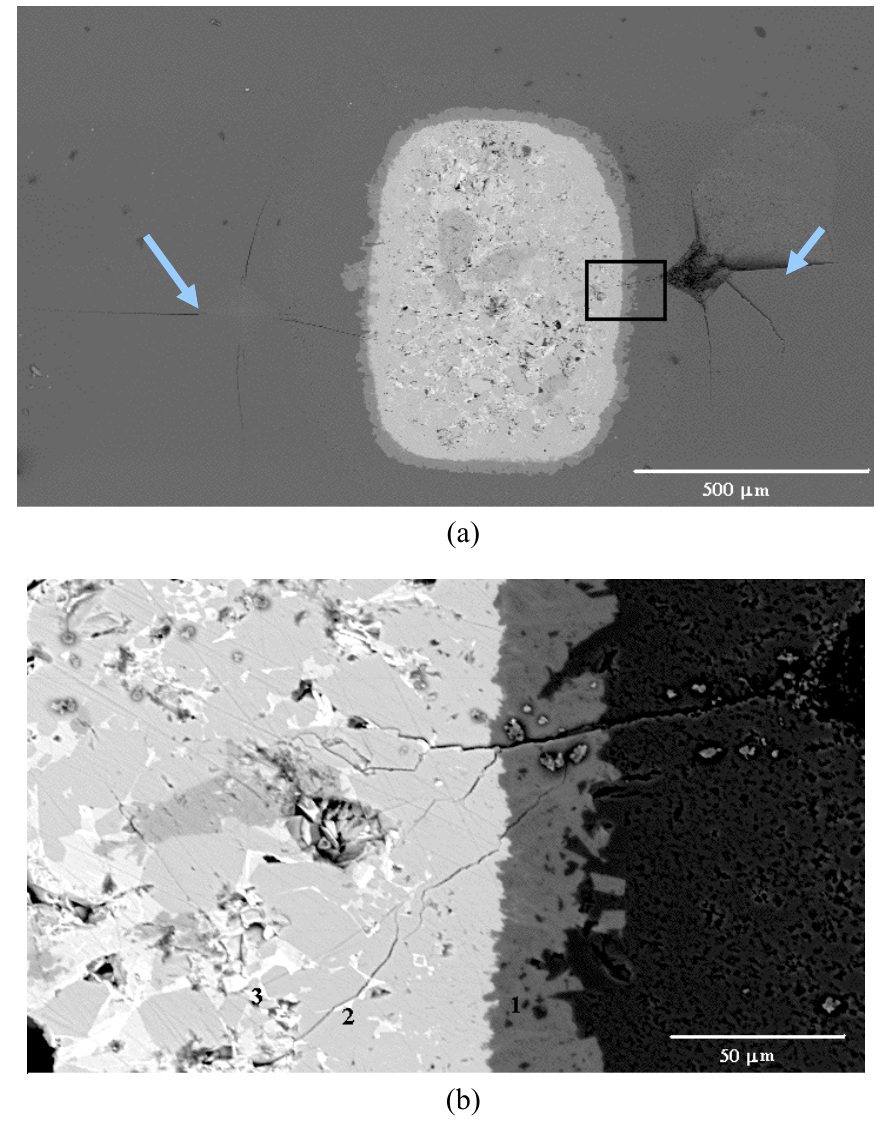
Figure 3. (a) A typical BaTiO indentations are arrowed. (b) Interactions between an indentation-induced crack and platelet.